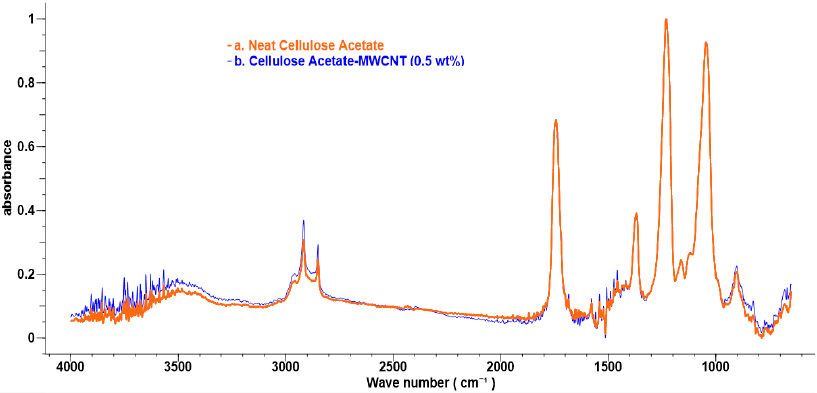
Figure 8. FTIR absorbance spectra of ( a ) neat CA ( b ) CA-MWCNT.